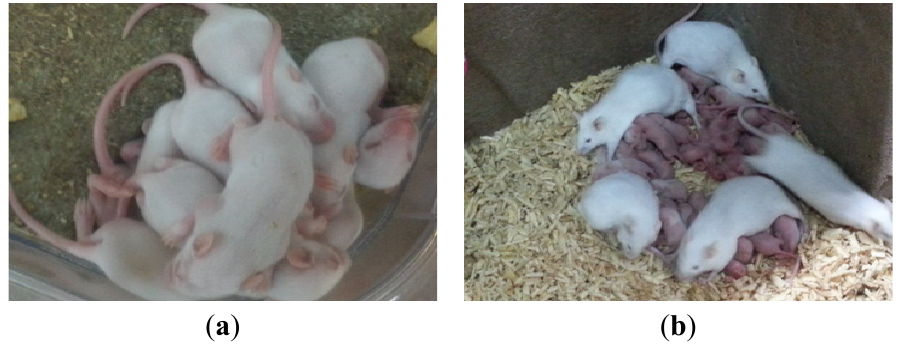
Figure 18. Breeding of ICR. ( a ) Floor cages and ( b ) Residence cage.